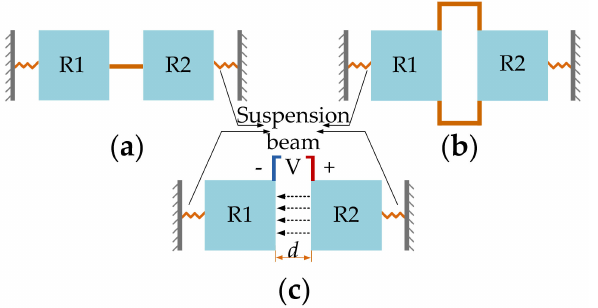
Figure 7. 2-DoF coupled BAW resonators with different coupling methods. ( a ) Fixed-fixed straight coupling beam; ( b ) Folded coupling beam; ( c ) Electrostatic coupling. Note: d is the lateral transduction gap between the resonator R1 and resonator R2, and the dotted arrow lines indicate the electric field direction.